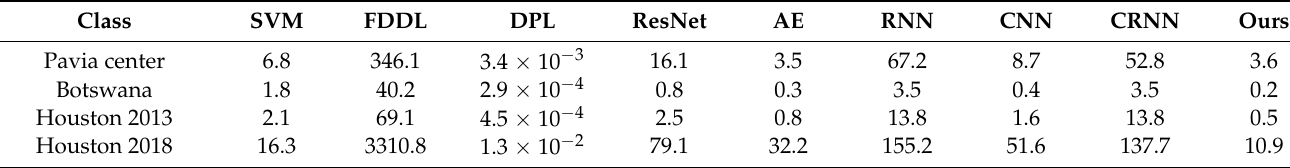
Table 7. Computational Costs for Different Classification Methods (In